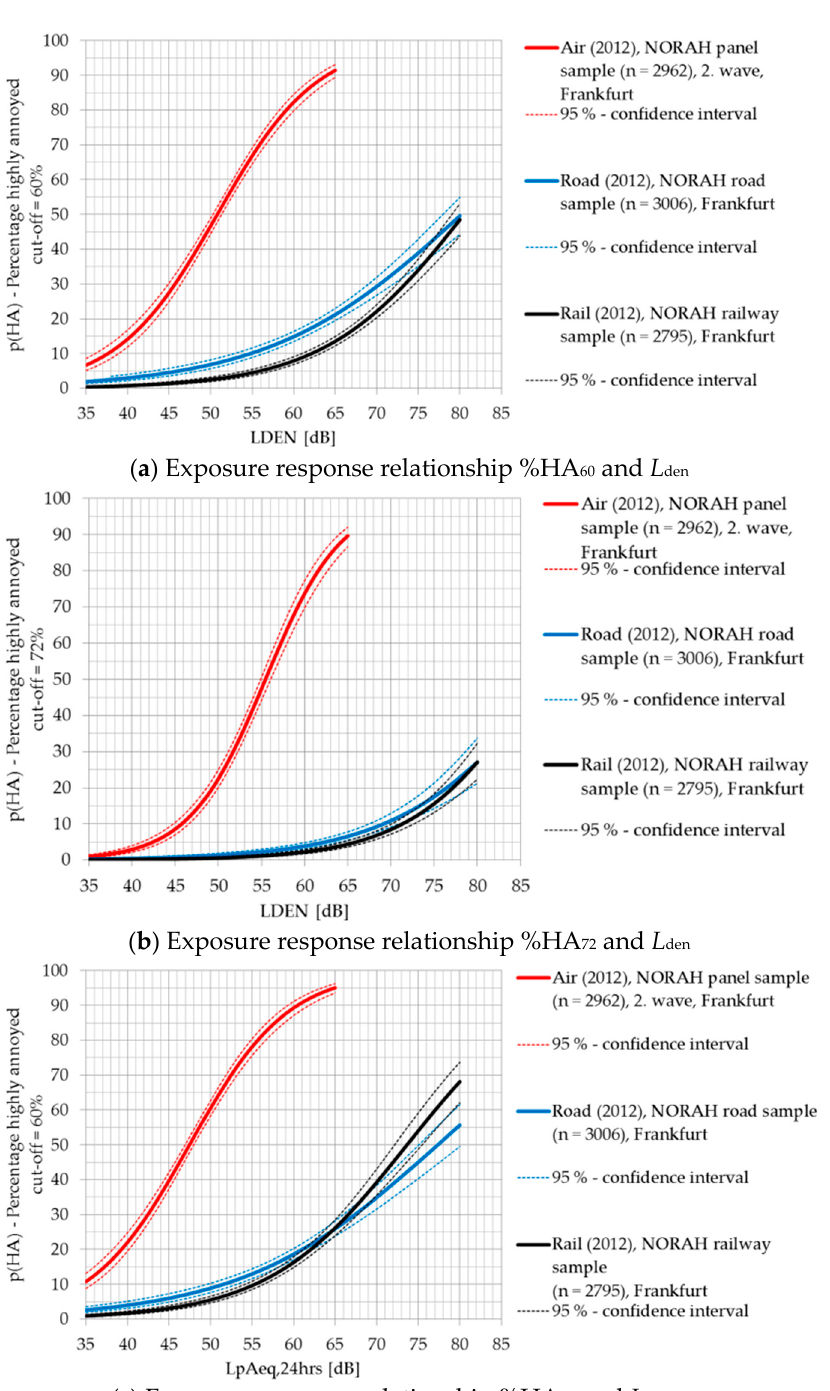
Figure 2. Exposure ‐ response relationship of the percentage of highly annoyed people (%HA) for aircraft noise (red), road traffic noise (blue), and railway noise (black) and the L den with a cut ‐ off for HA of ( a ) 60% and ( b ) 72%; or ( c ) the L pAeq,24h .with a cut ‐ off for HA of 60%.